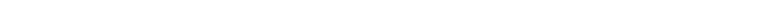
Algorithm 3 Balance